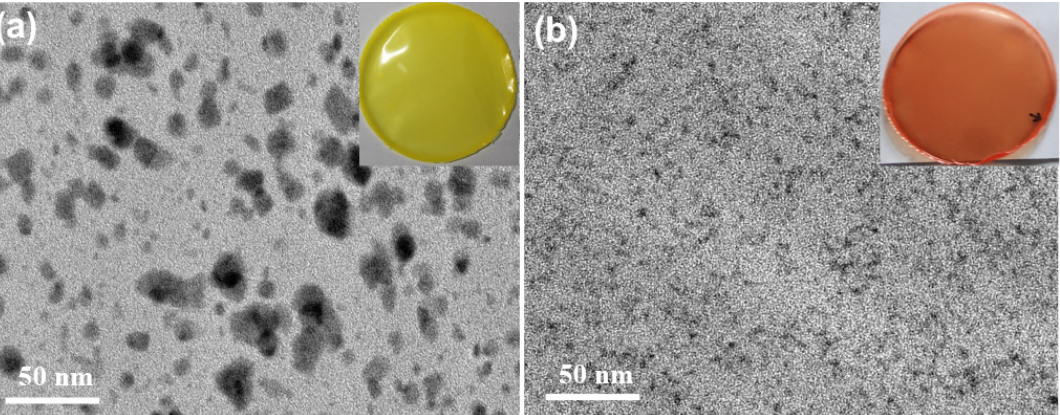
Figure 5. ( a ) TEM images of green emissive CuInS 2 NCs in PMMA matrix; ( b ) TEM images of red emissive CuInS 2 NCs in PMMA matrix.